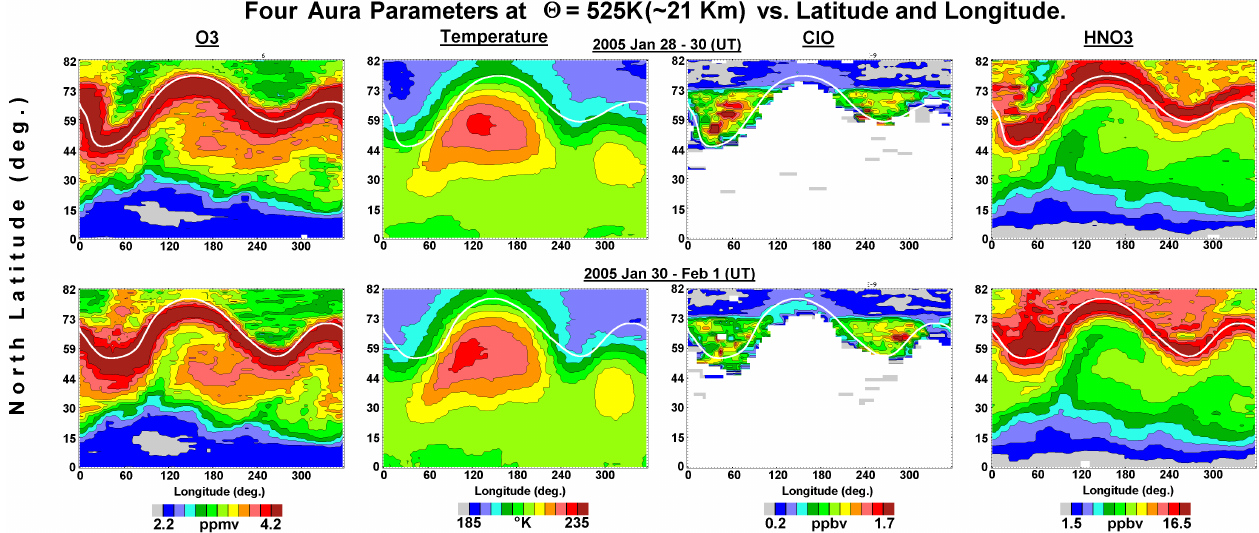
Fig. 11. Polar cylindrical hemispheric contour plots of the 3-day average mixing ratios of ozone, temperature, chlorine monoxide and nitric acid (Aura MLS). These are for two days (29 and 31 January) within the 1 February “warming event” as defined in Sect. 3. The edge of the polar vortex as determined by the Q-diagnostic using MetO (data assimilation model) is shown in white (see